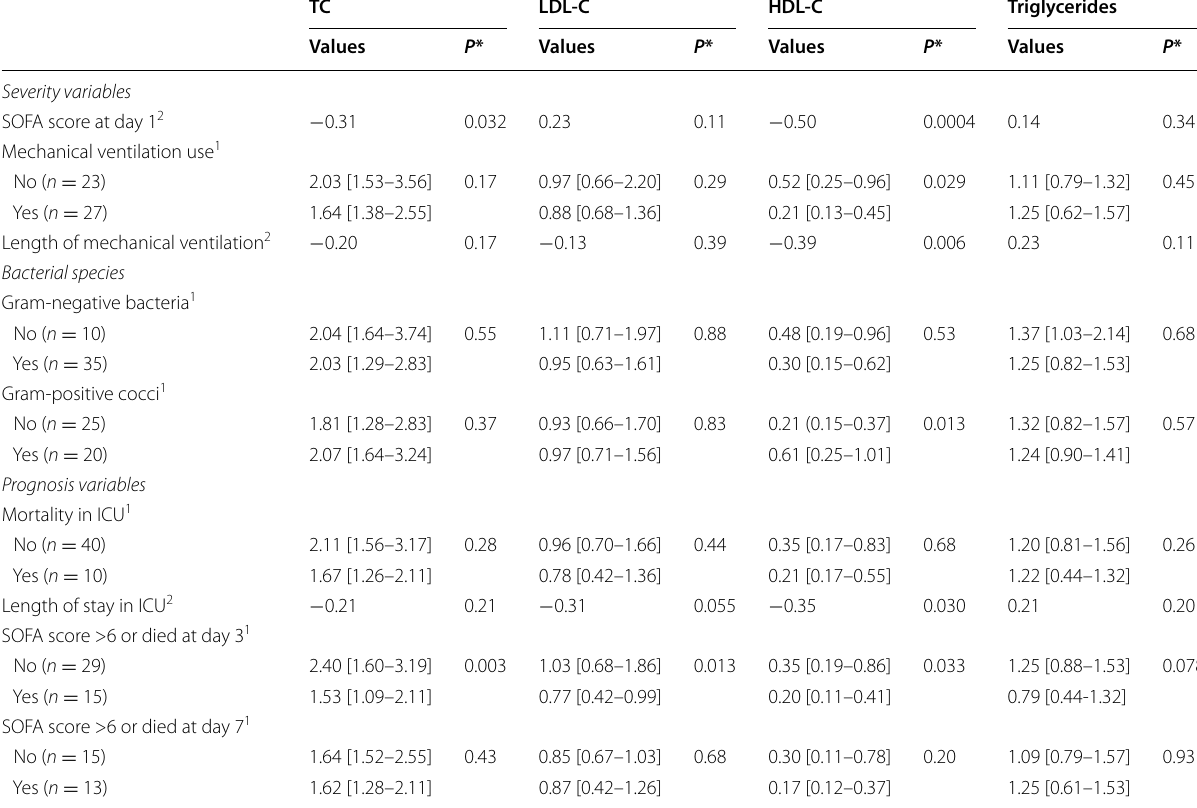
Table 2 Association of lipid levels with sepsis severity and short-term